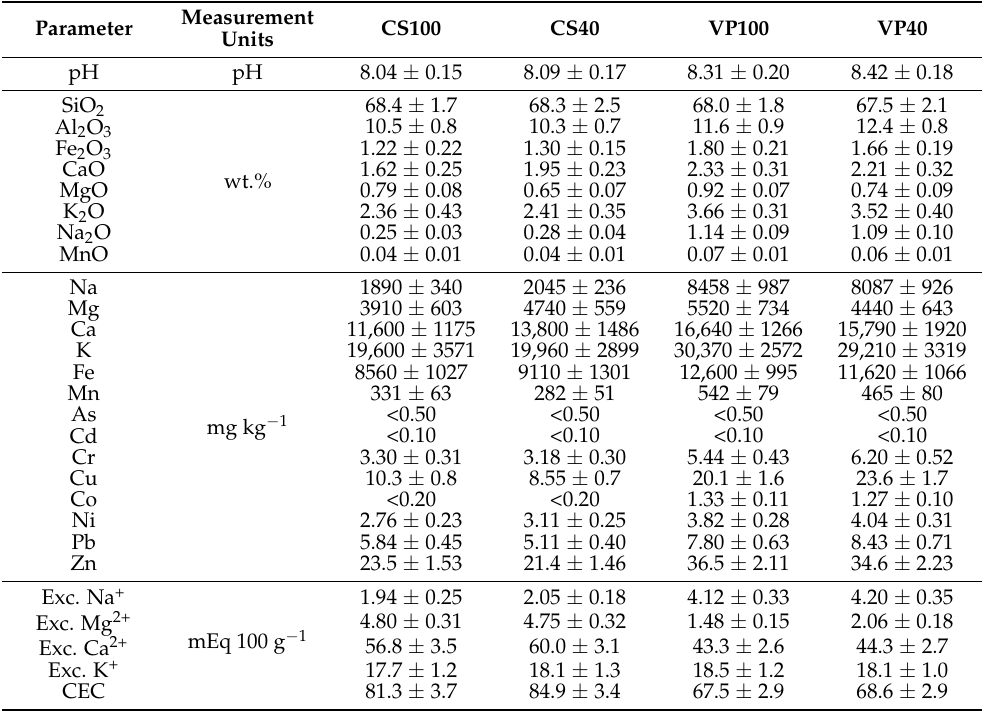
Figure 4. X-ray diffraction patterns of the zeolitic tuff micronized at <100 and <40 µm, thermally treated at 450 °C: ( a ) Chilioara and ( b ) Valea Pomilor. The chemical composition, in terms of the major oxides and inorganic components, pH, exchangeable cations, and total exchange capacity of the four samples (CS100, CS40, VP100, VP40) thermally treated at 450 °C, are presented in Table 3. Table 3. Chemical properties of micronized and thermally treated zeolites (average ± t × s, n = 3 parallel measurements).